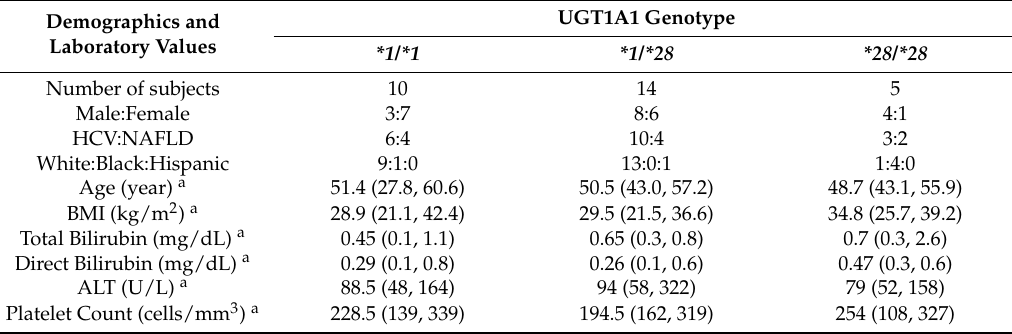
Table 2. Demographic characteristic of subjects in the three study groups based on genotype of